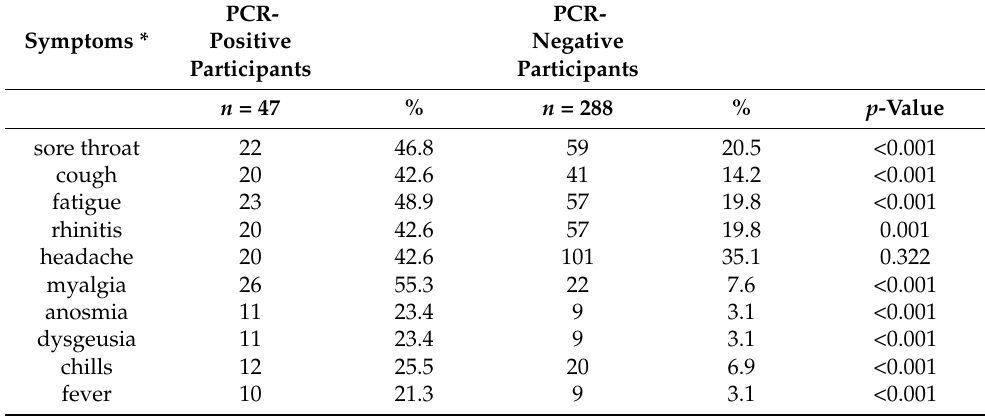
Table 4. Clinical characteristics of PCR-tested participants with known COVID-19